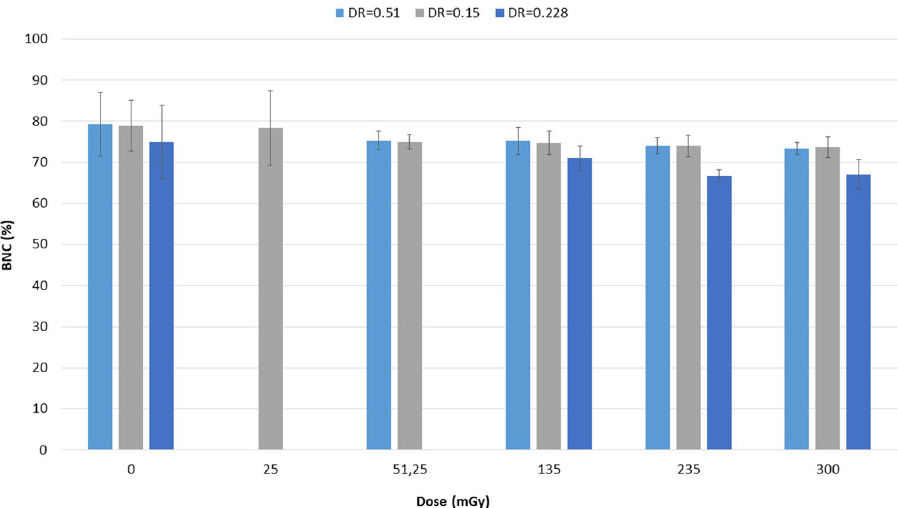
Figure 10. Frequencies of binucleated cells (BNC). In all irradiated samples the frequencies of BNC were lower than the unirradiated controls although not statistically significant. Dose rate (DR) is expressed in